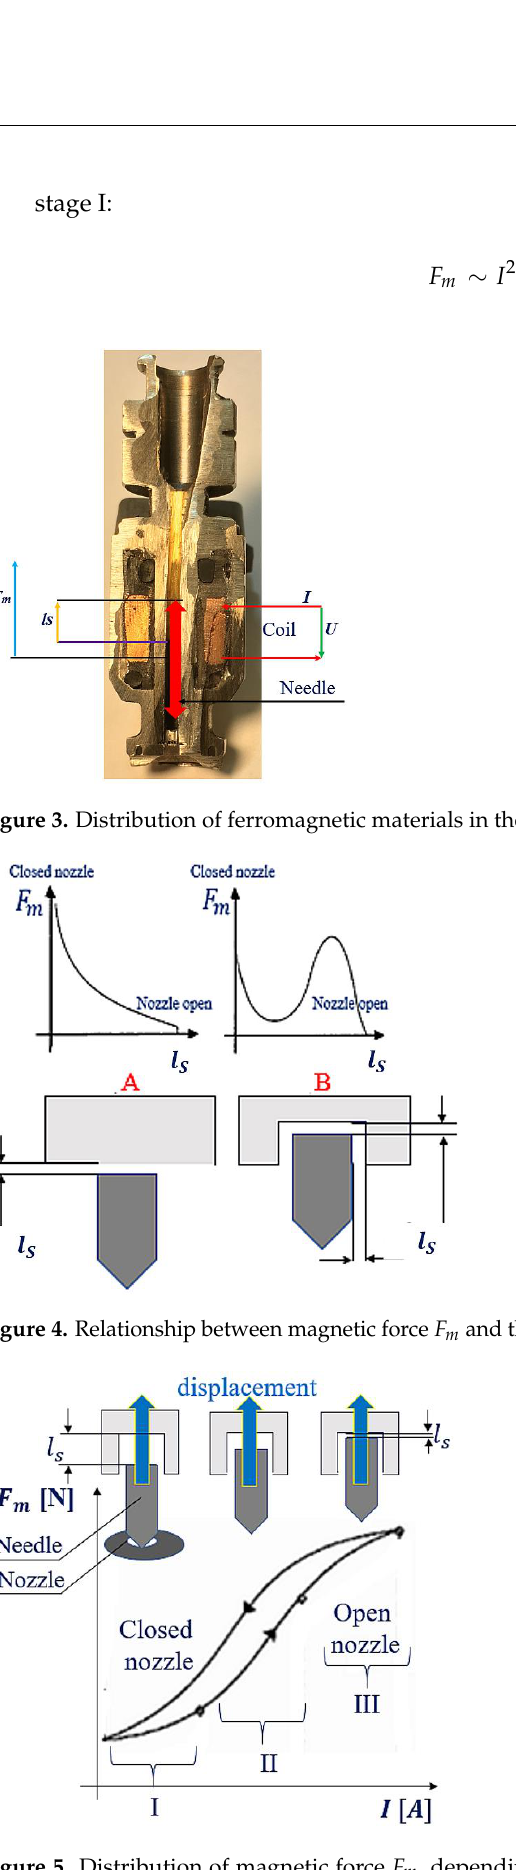
Figure 6. Comparison of the current waveforms of the RL circuit, performing the work and non- performing.